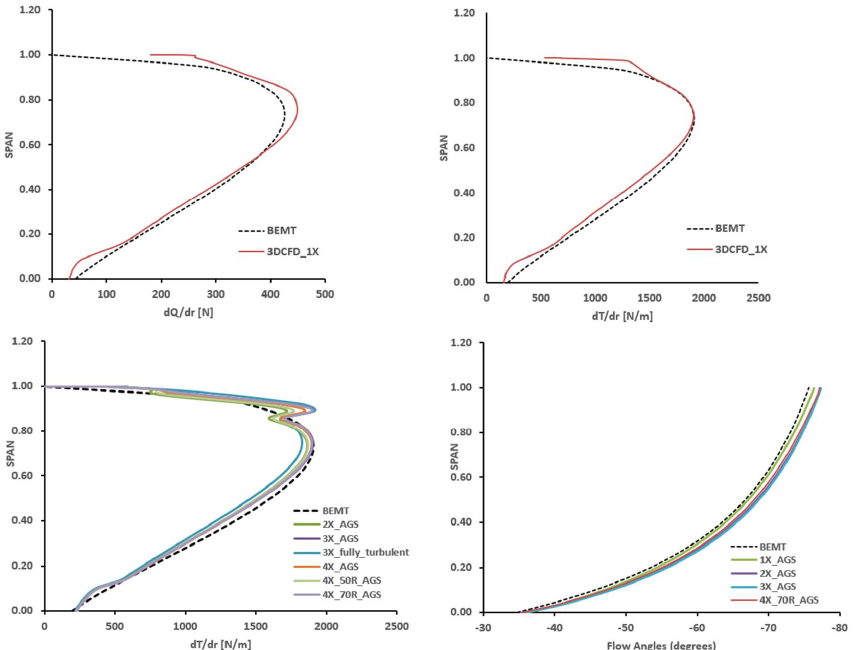
Figure 15. Spanwise distribution of thrust and torque compared between py_BEM and 1X 3D CFD domain; thrust and flow angle distribution compared with several 3D CFD domain steady solutions for the reverse-engineered solo